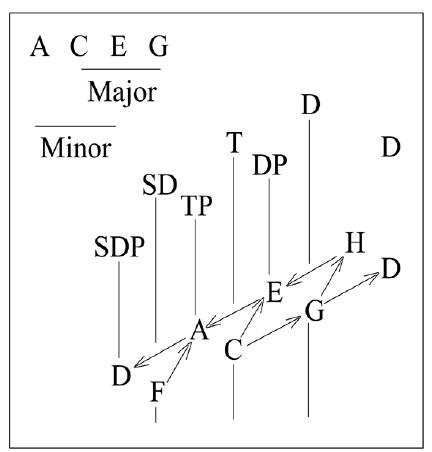
FIGURE 11. The strategy for the development of the major and minor parallelism.